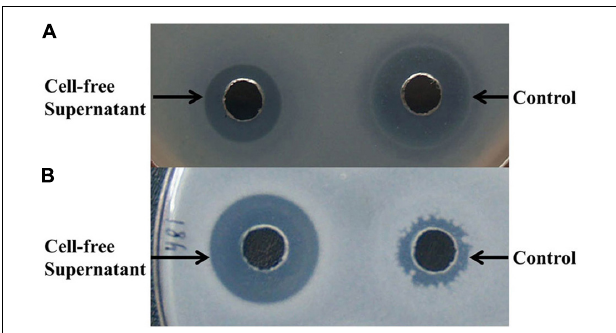
FIGURE 2 | Assay of antibacterial activity against E. coli DH5 α (A) and Lactobacillus sp. PL17 (B) . (A,B) 50 µ L of samples were added into the wells; cell-free supernatant was obtained after 18 h of fermentation by B. subtilis D21-8 using the non-sterile basal medium; control: 100 µ g/mL ampicillin.